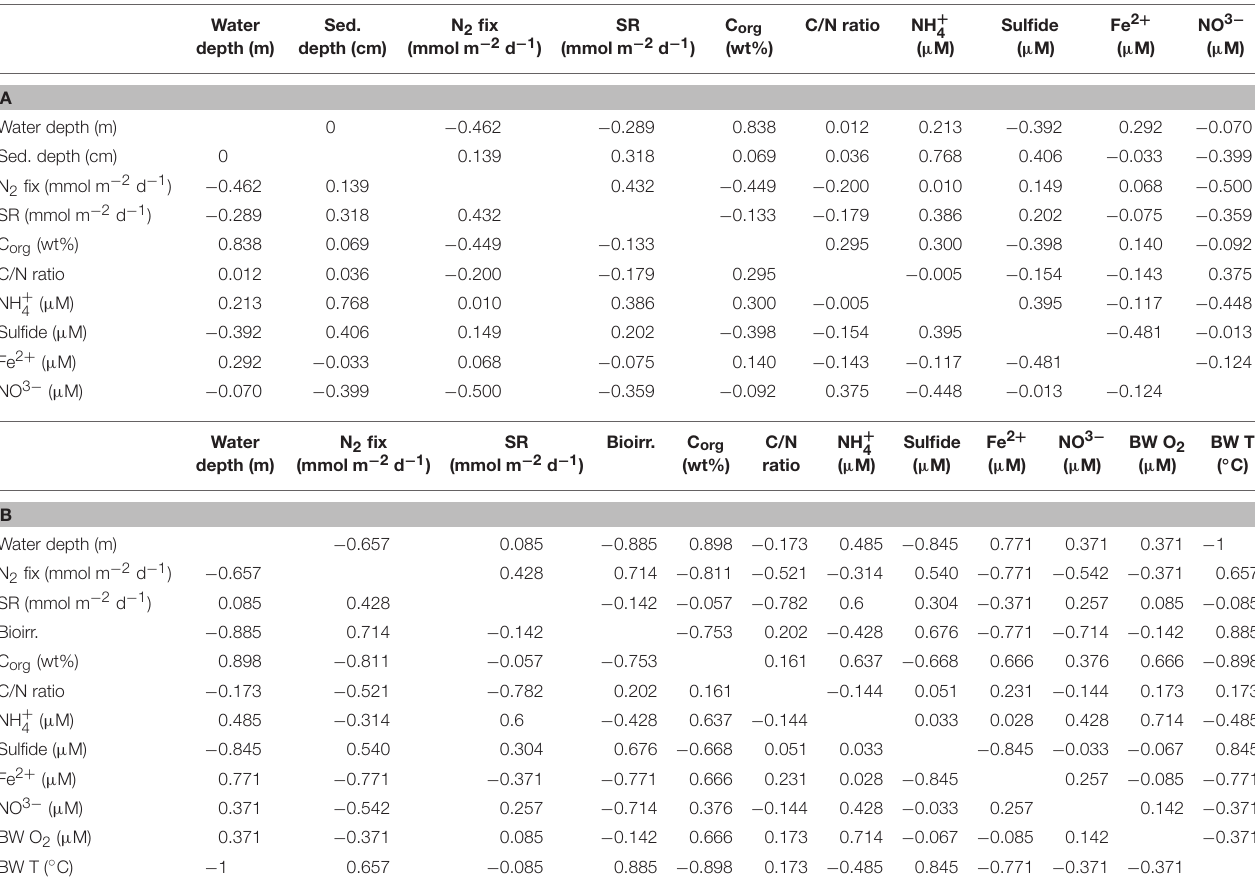
TABLE 2 | Statistical analysis of Pearson correlation coefficients including r -values along (a) vertical depth profiles, and (b) integrated rates and means of environmental variables. Water depth